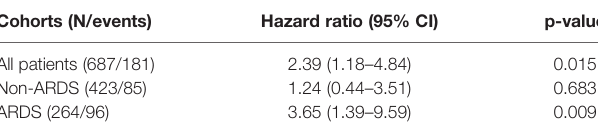
TABLE 2 | Association results of wb-mtDNA copy number with 28-day mortality. Cohorts (N/events)